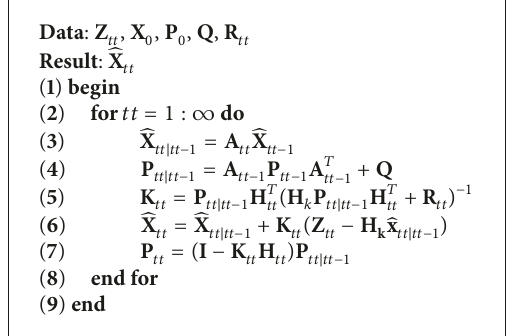
Algorithm 1: Kalman filter algorithm for the self-contained scheme.